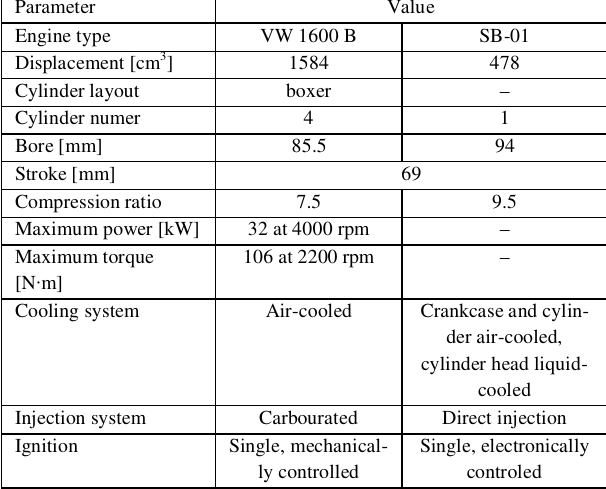
Table 2. Technical data of the basic and prototype engine